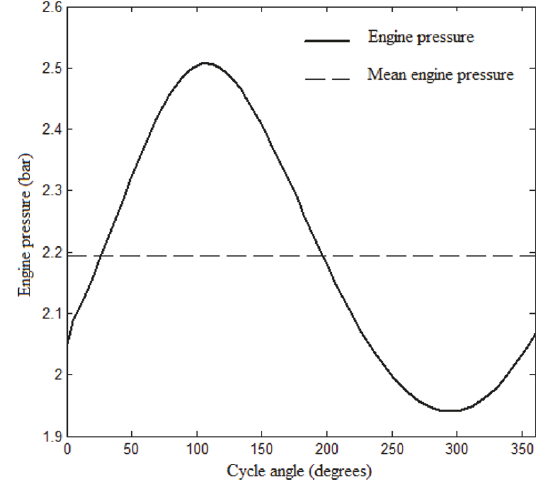
Figure 9: Engine pressure variation.